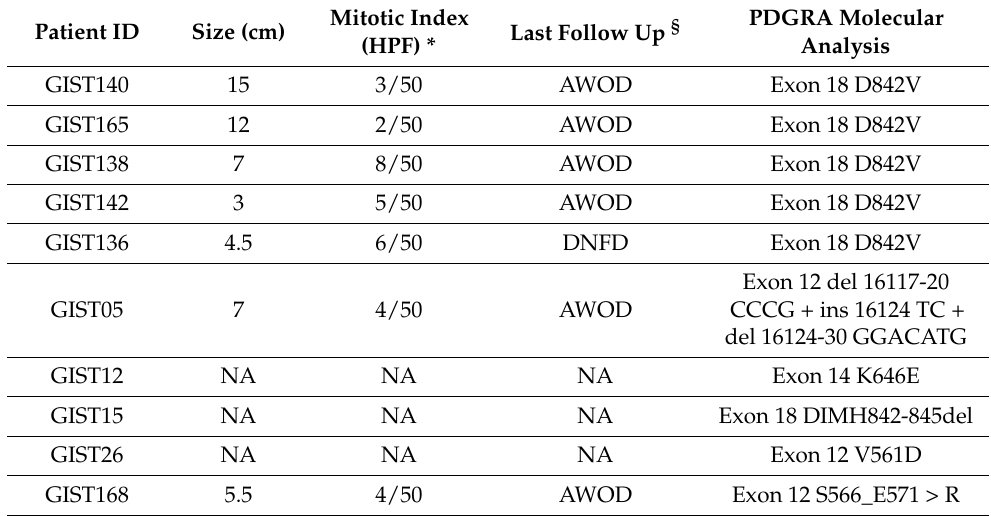
Table 3. Patients’